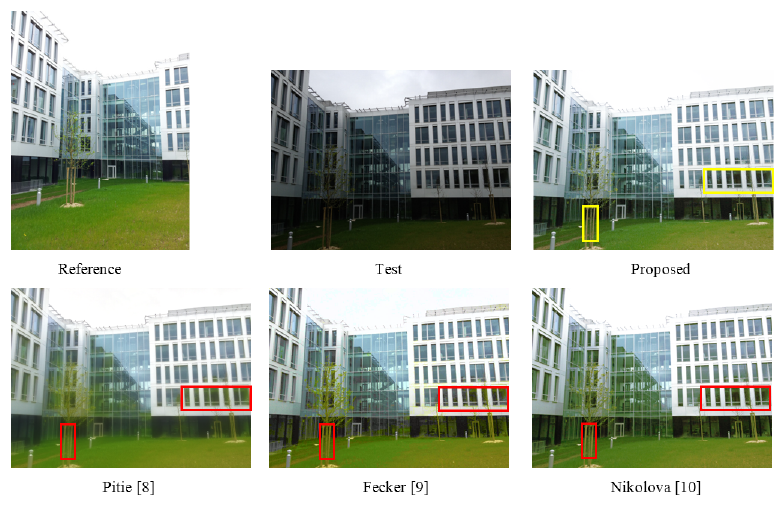
Figure 7. Comparison for the real image pair. Image Source: courtesy of the authors and databases referred on [29].